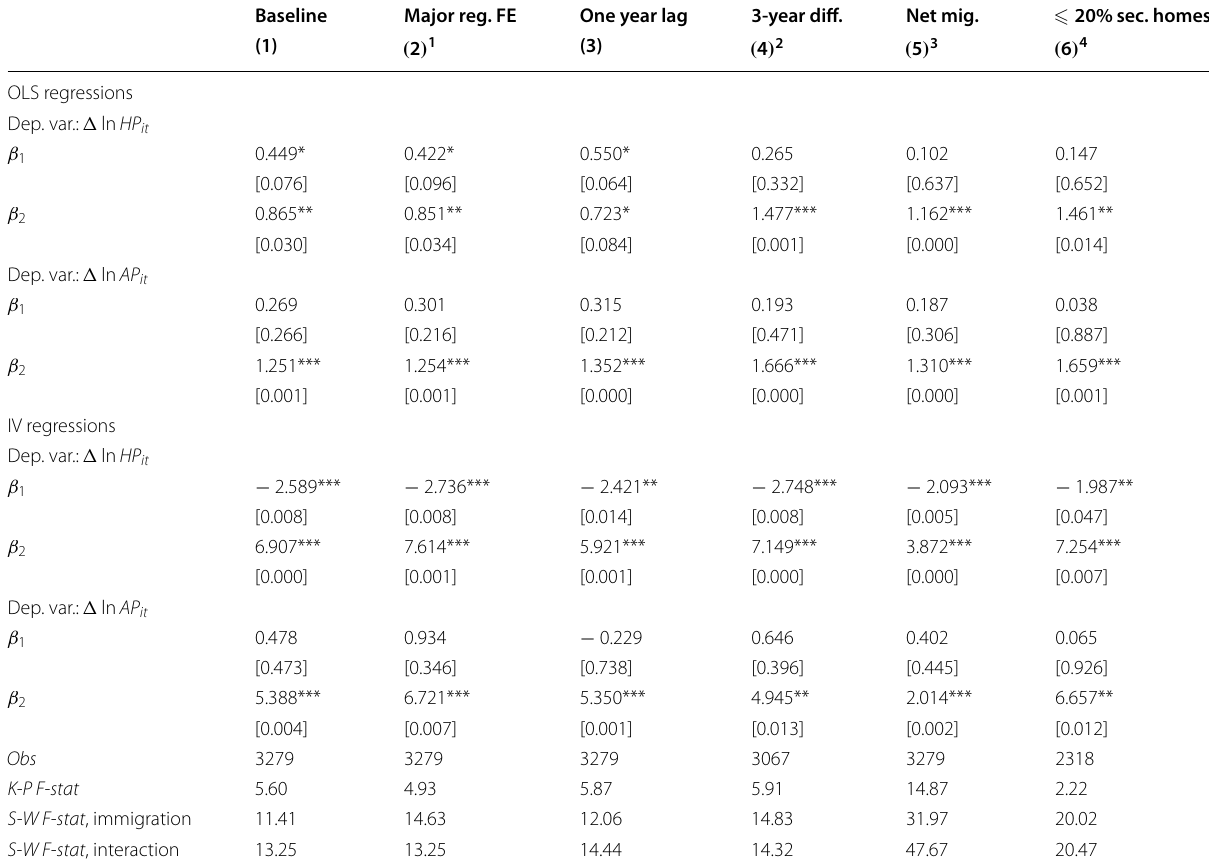
Table 9 House prices and immigration—MS-regions from 1985–2016: Sensitivity analysis. Source: Own calculations based on data from Wüest Partner and Federal Statistical